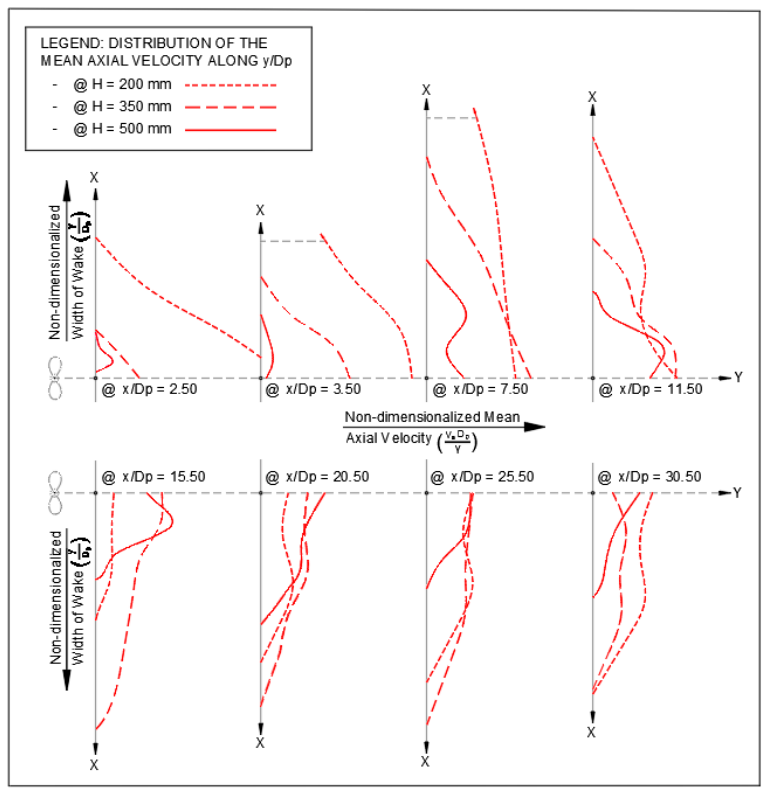
Figure 7. The approximate patterns of the distribution of the non-dimensionalized mean axial velocities (cid:16) (cid:17) (cid:4673) along y/Dp with the change of ‘H’.